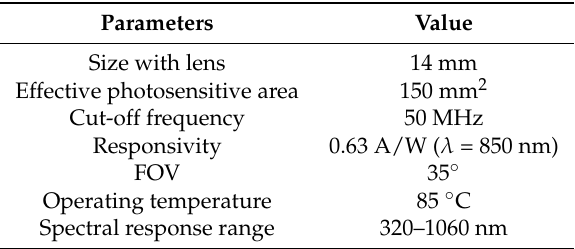
Table 1. Parameters of Hamamatsu S6968 Si-PIN